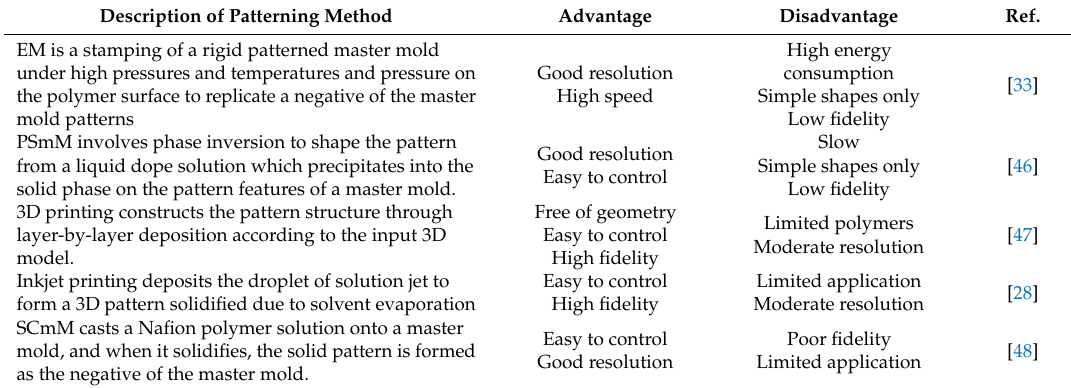
Table 1. Summary of membrane surface patterning